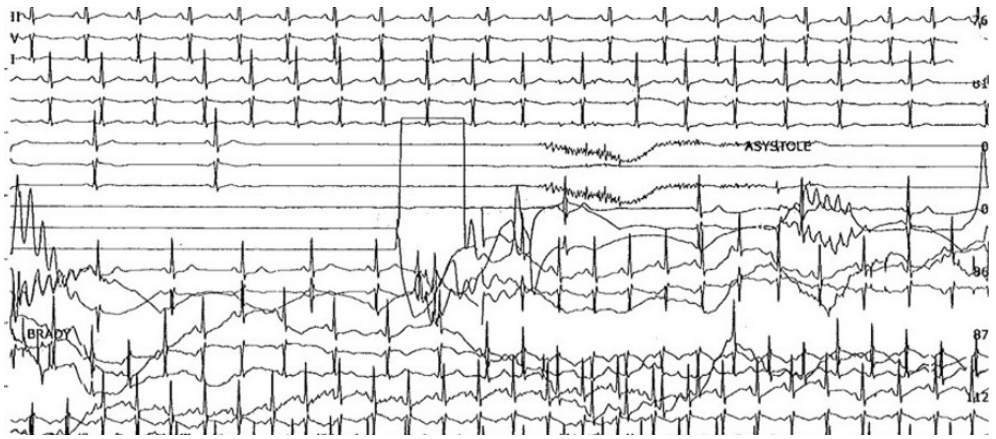
Figure 4. Example of cardioinhibitory response captured on electrocardiogram in neurally mediated syncope: the inhibitory effect of vagus stimulation on the sinus node results in progressive bradycardia, followed by asystole without P-waves and acceleration of the sinus rhythm in the second part of the tracing.